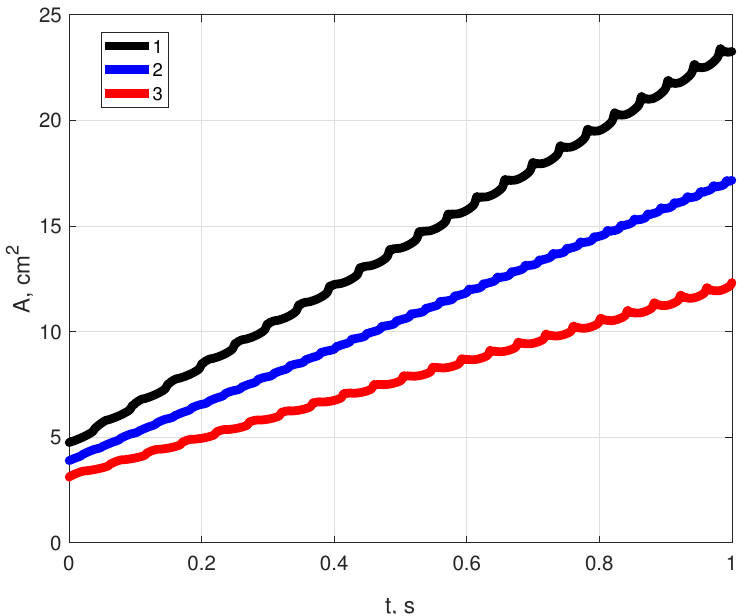
Figure 1. The values of the vascular cross-section in the chosen points: 1— A ( t ,0 ) ; 2— A ( t , l /2 ) ; and 3— A ( t , l ) .